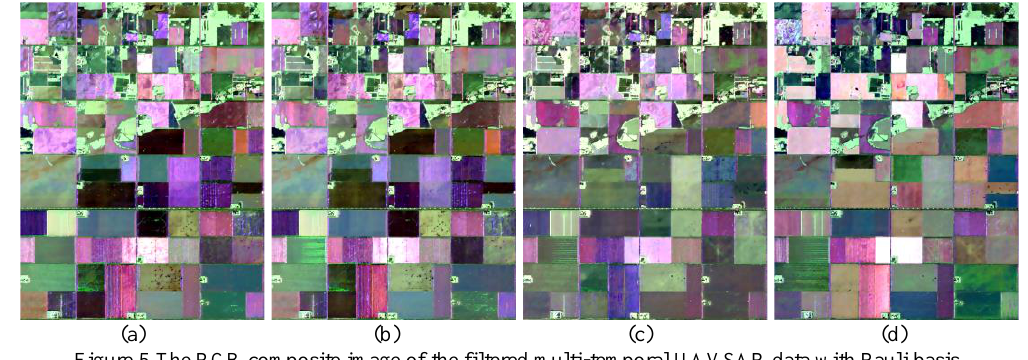
Figure 5 The RGB composite image of the filtered multi-temporal UAVSAR data with Pauli basis.